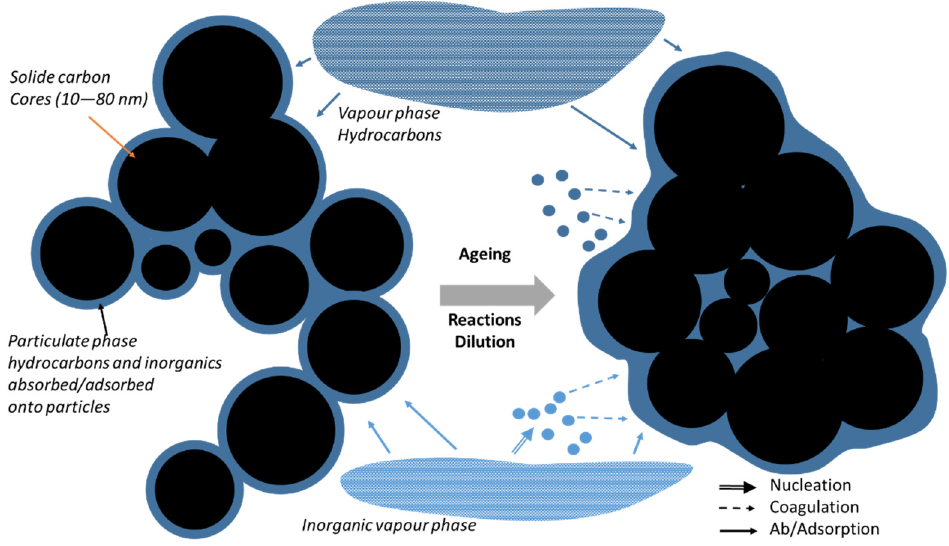
Figure 5. Schematic representation of diesel particulate matter (PM) formed during combustion of atomised fuel droplets and its evolution during the dilution until ambient conditions. The resulting carbon cores agglomerate and adsorb species from the gas phase.